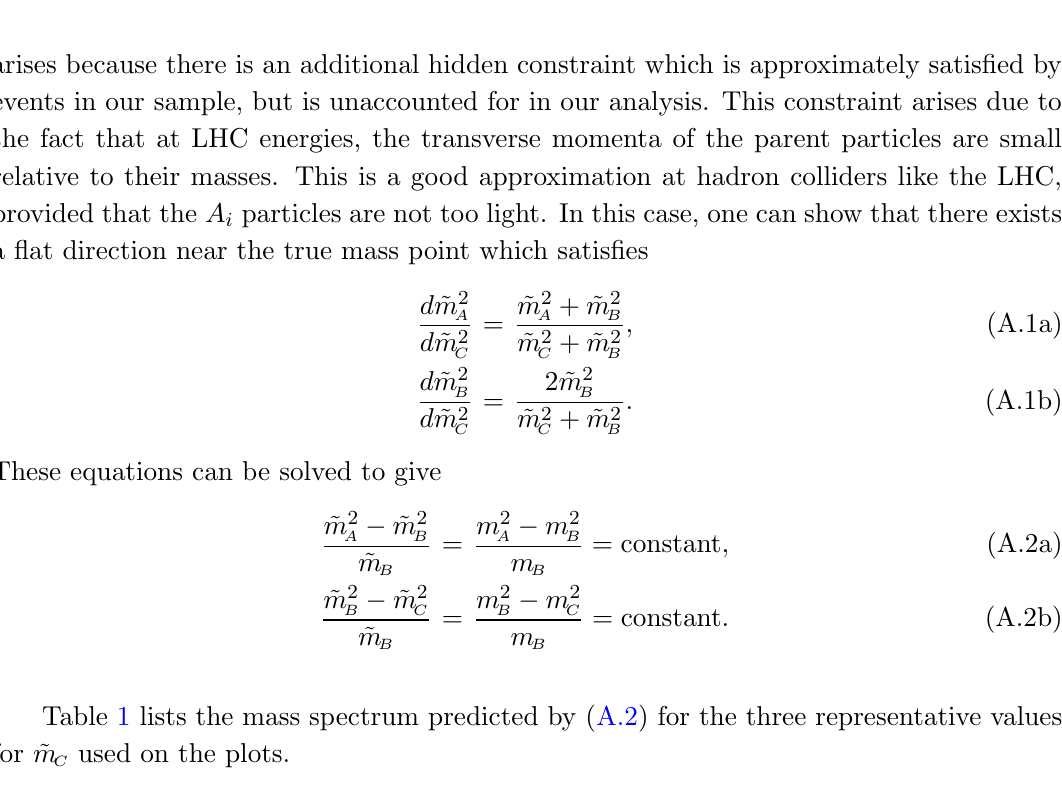
values used in the C